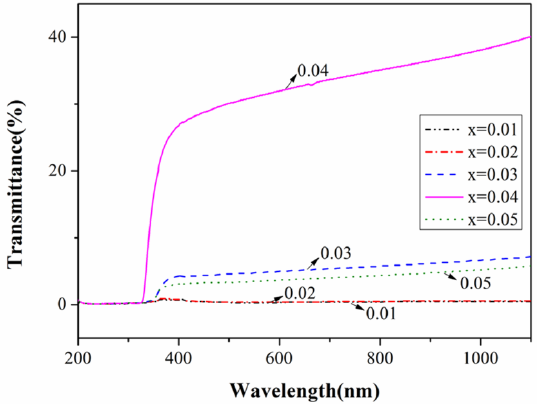
Fig. 22 Transmittance of Y 2+ x Ti 2 O 7+3 x /2 ceramics vacuum sintered at 1600 ℃ for 6 h and annealed at 1000 ℃ for 6 h (0.5 mm thick). Reproduced with permission from Ref. [102], © Elsevier Ltd.